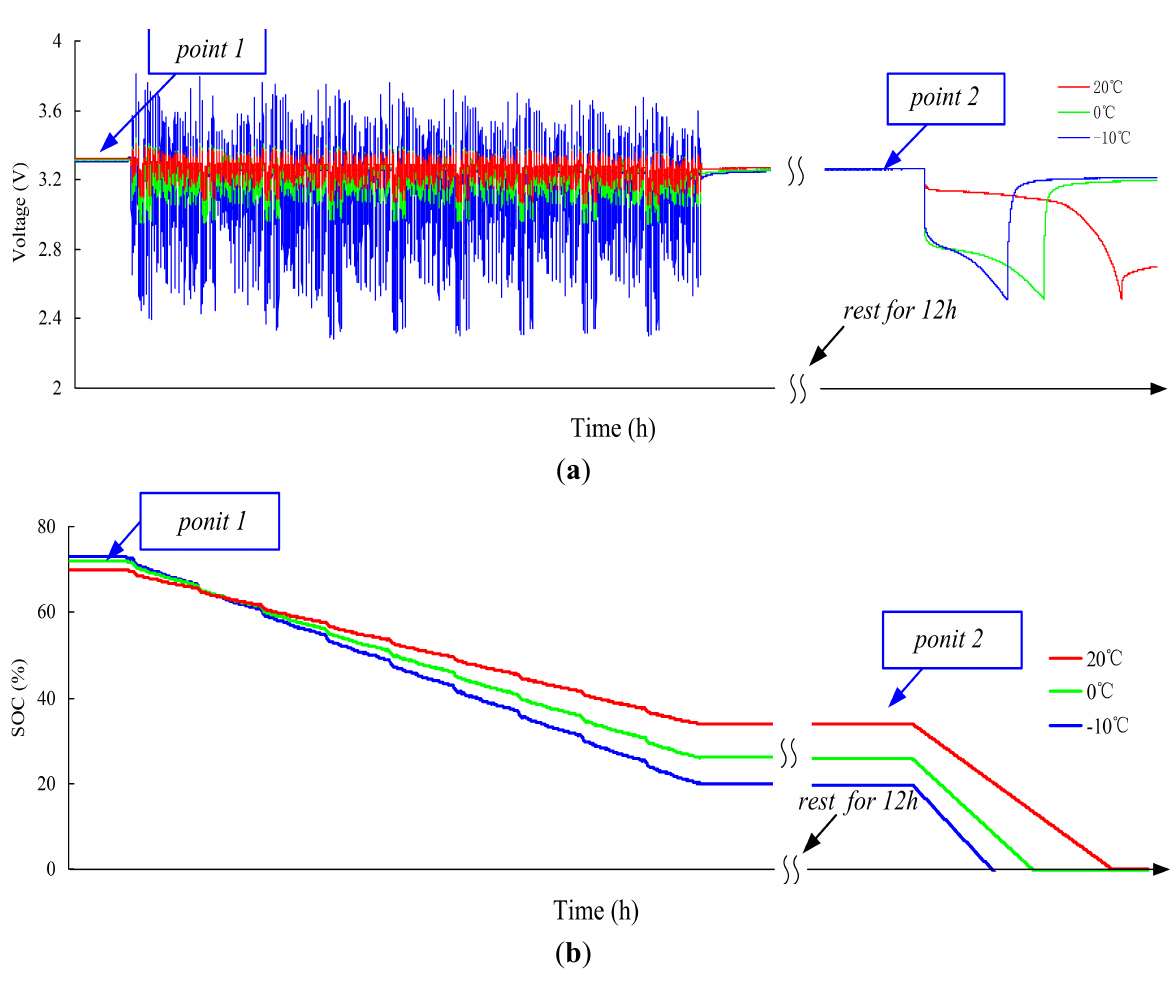
Figure 19. FUDS cycle test at constantly varying temperatures. ( a ) Voltage curves; ( b ) SOC